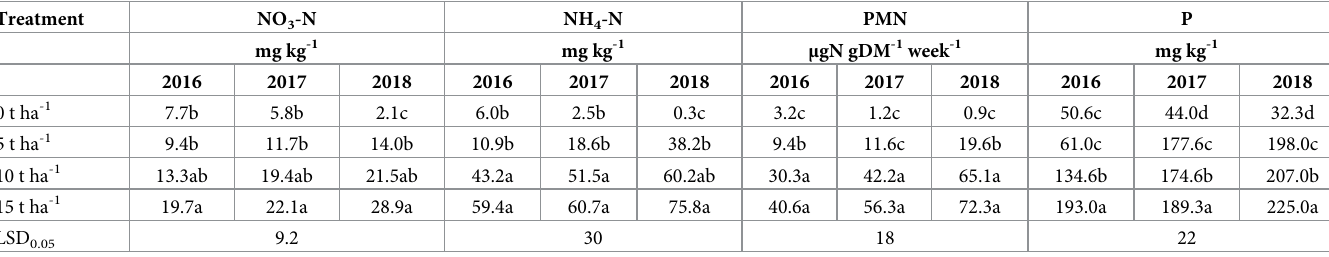
Table 6. Soil NO 3 -N, NH 4 -N, PMN and P as influenced by compost application rates at the Mooketsi orchard from 2016 to 2018. Treatment